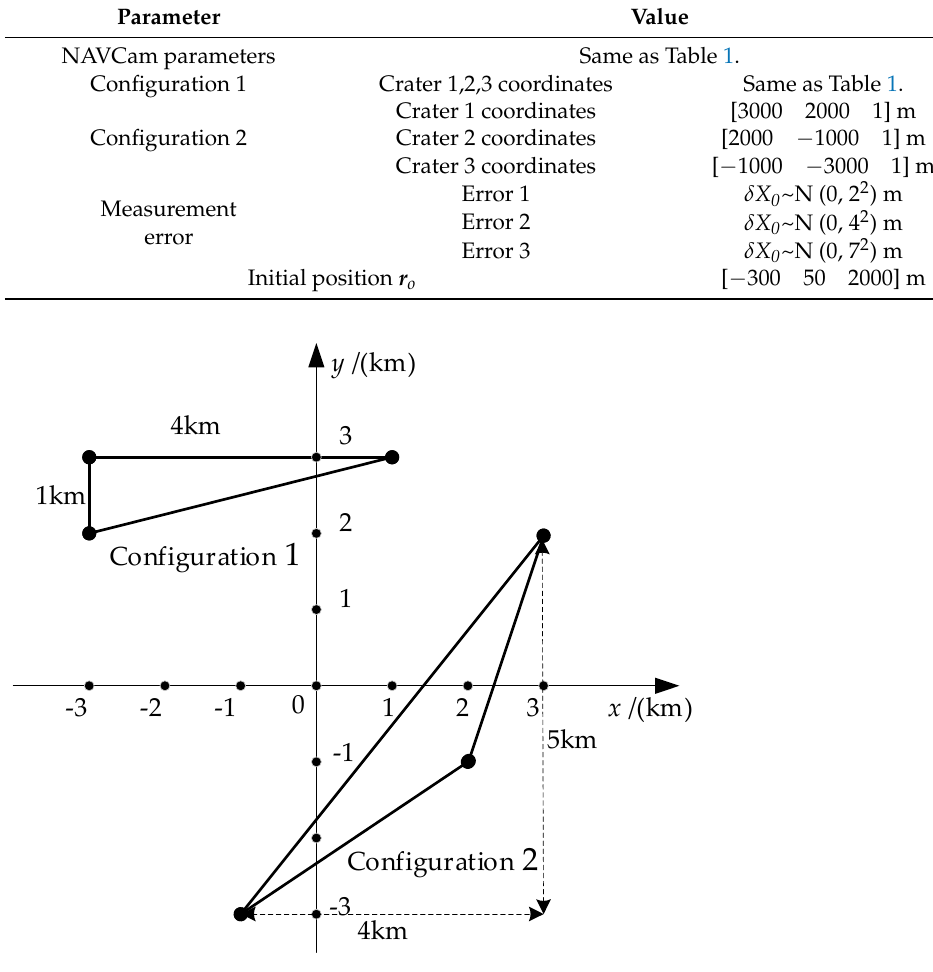
Figure 12. Two crater distribution configurations.